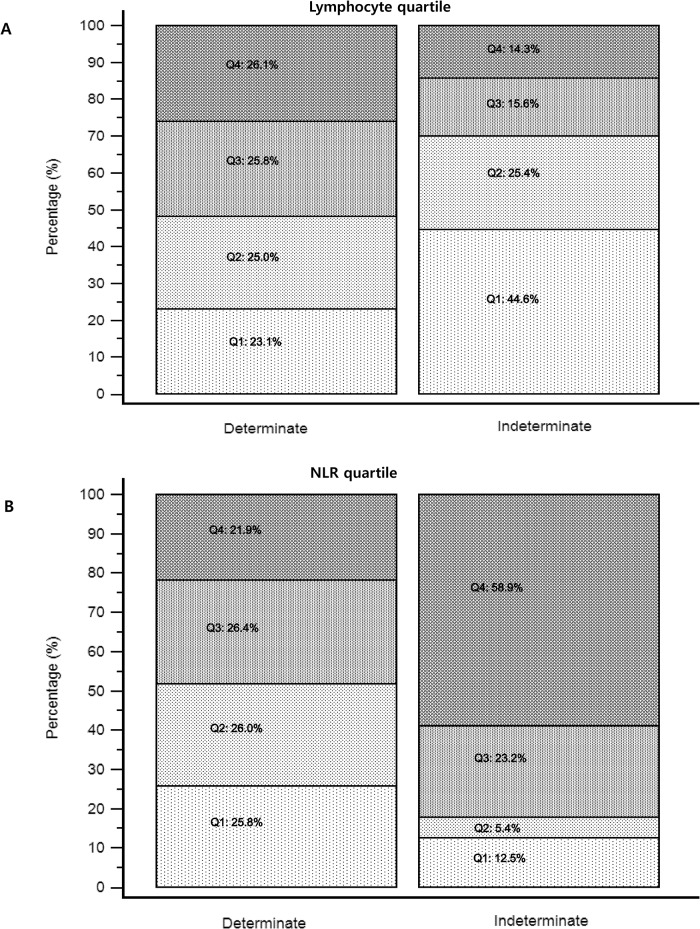
Distribution of lymphocyte quartiles and neutrophil-to-lymphocyte ratio (NLR) quartiles in determinate and indeterminate QuantiFERON-TB Gold In-Tube (QFT-GIT) assay results (n = 2773).(A) Lymphocyte quartiles (per μL) (p<0.0001 by Chi-squared test) Q1;≤1050 Q2;1051–1510 Q3;1511–2093 Q4;≥2094 (B) NLR quartiles (p<0.0001 by Chi-squared test) Q1;≤1.7 Q2;1.71–2.84 Q3;2.85–5.17 Q4;≥5.18. Positive and negative results of QFT-GIT are considered as “determinate”.